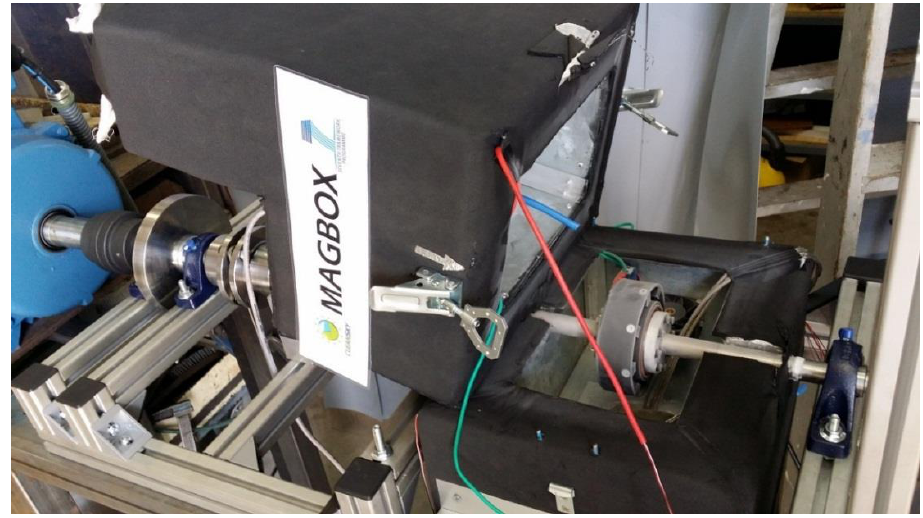
Figure 11. Aeronautical torque limiter (black inside the chamber) after low temperature test.